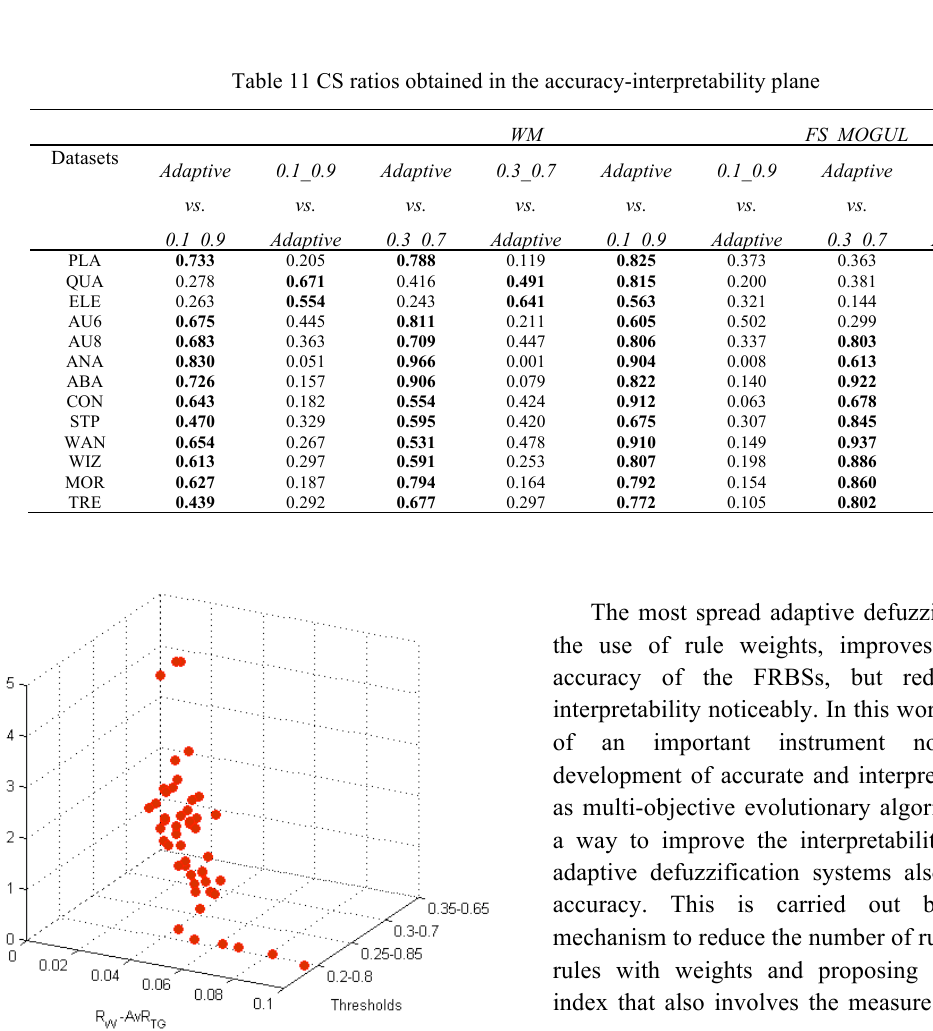
Fig. 5. Example Pareto fronts and Thresholds obtained in MOR problem